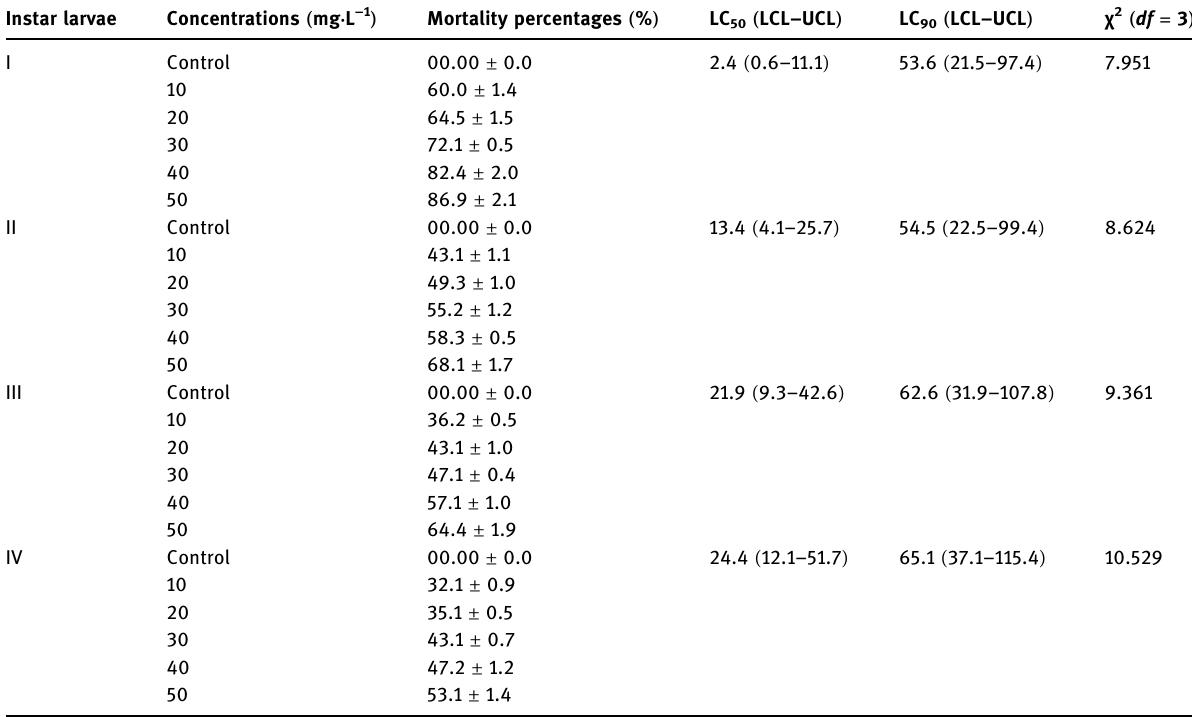
Table 1: Larvicidal activity of CuO - NPs against I, II, III, and IV instar larvae of Culex antennatus Instar